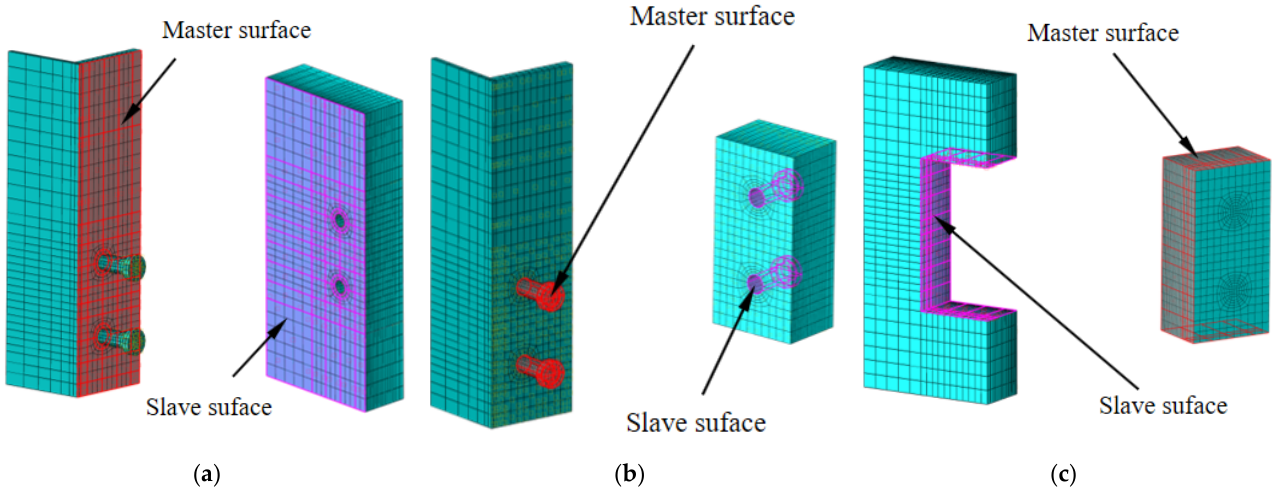
Figure 8. Contact conditions of the FEM model: ( a ) steel beam-to-concrete slab; ( b ) head stud-to- concrete; ( c ) precast slab-to-shear pocket.